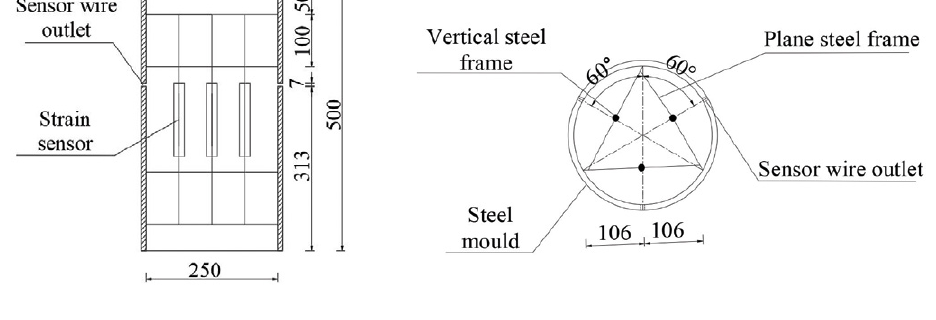
Figure 2. Design drawing and instrumentation